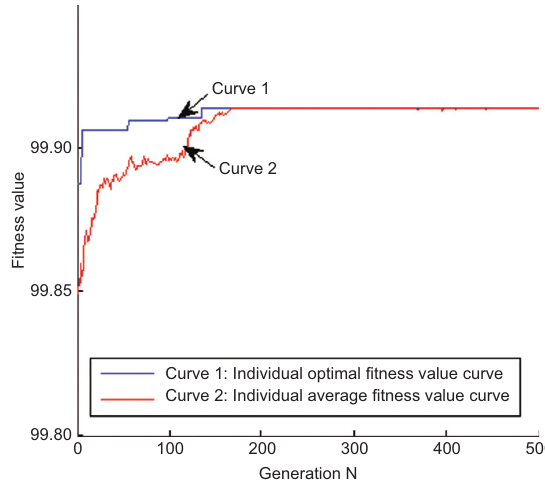
Figure 10. The Convergence Curve when the Crossover Probability is Set to (0.6, 0.4).